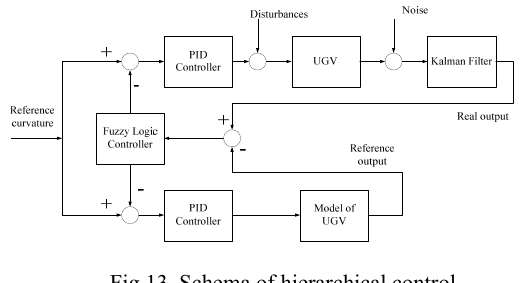
Fig.13. Schema of hierarchical